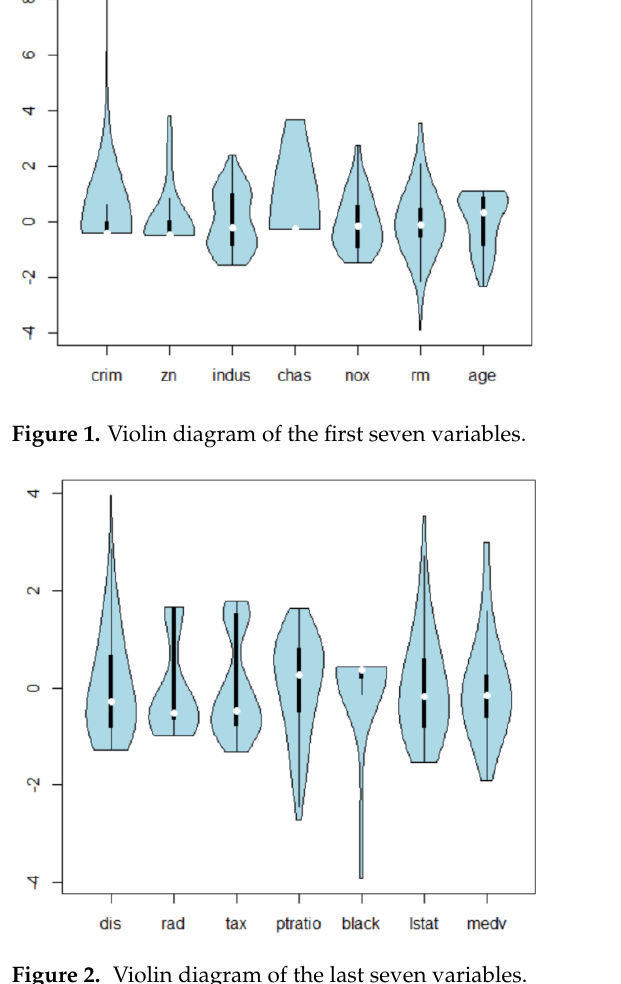
Figure 2. Violin diagram of the last seven